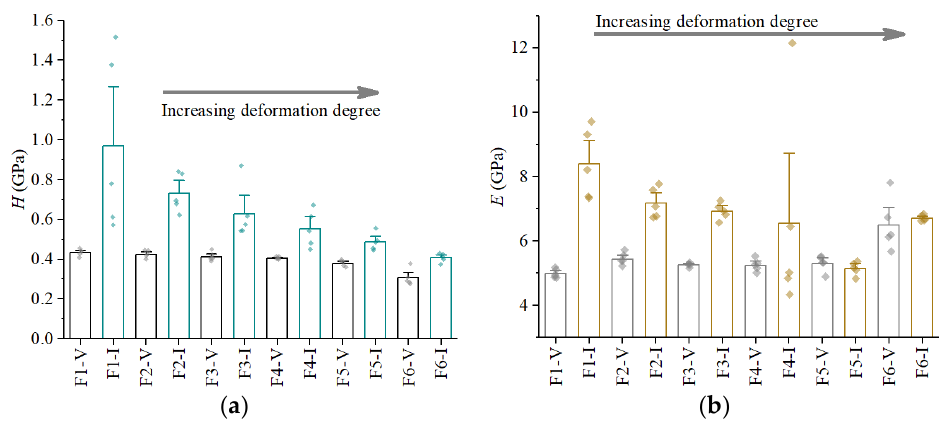
Figure 7. Distributions of H and E ( H is the hardness; E is the elastic modulus; ( a ) and ( b ) are the distributions of H and E , respectively).